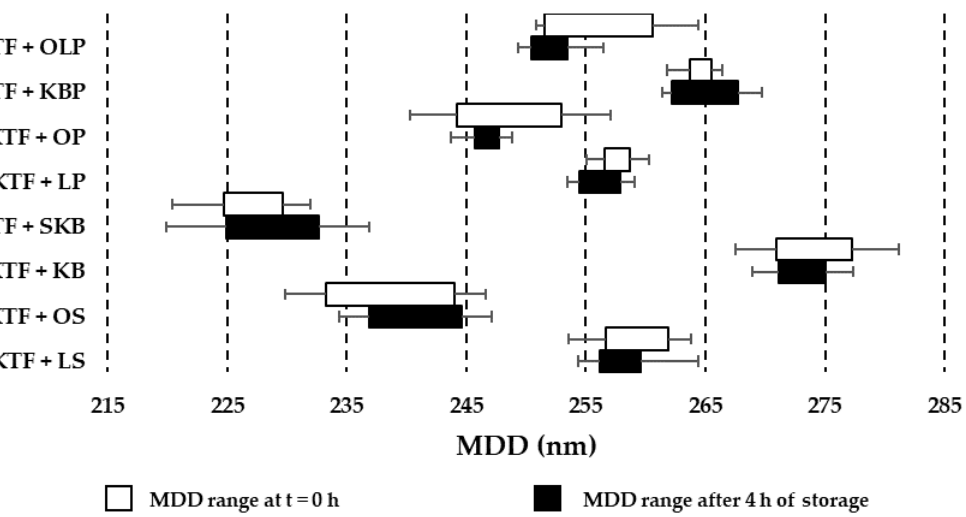
Figure 2. Results of MDD of lipid emulsion ranges for KTF and parenteral nutrition admixtures combinations.